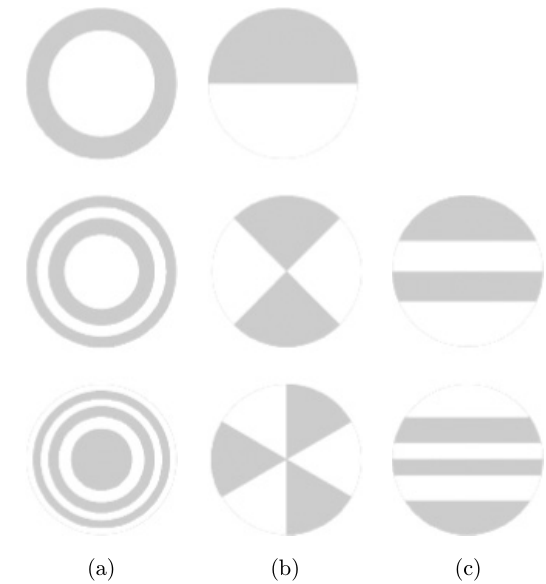
Fig. 7. Annular (a), fan-shaped (b), and stripe-shaped (c)